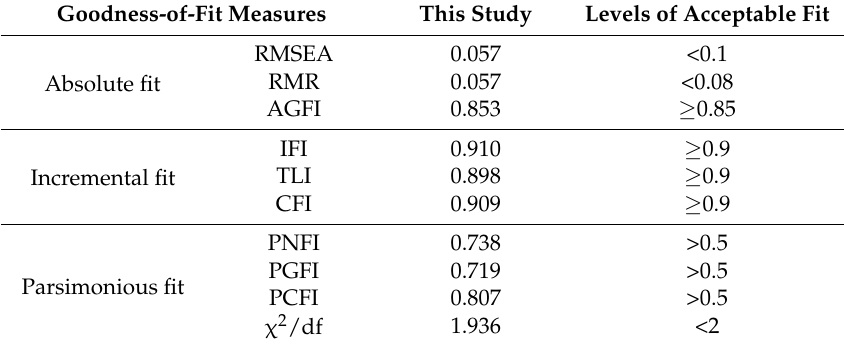
Table 4. Overall goodness-of-fit of the structural equation model. RMSEA: root-mean-square error of approximation; RMR: root-mean-square residual; AGFI: adjusted goodness-of-fit index; IFI: incremental